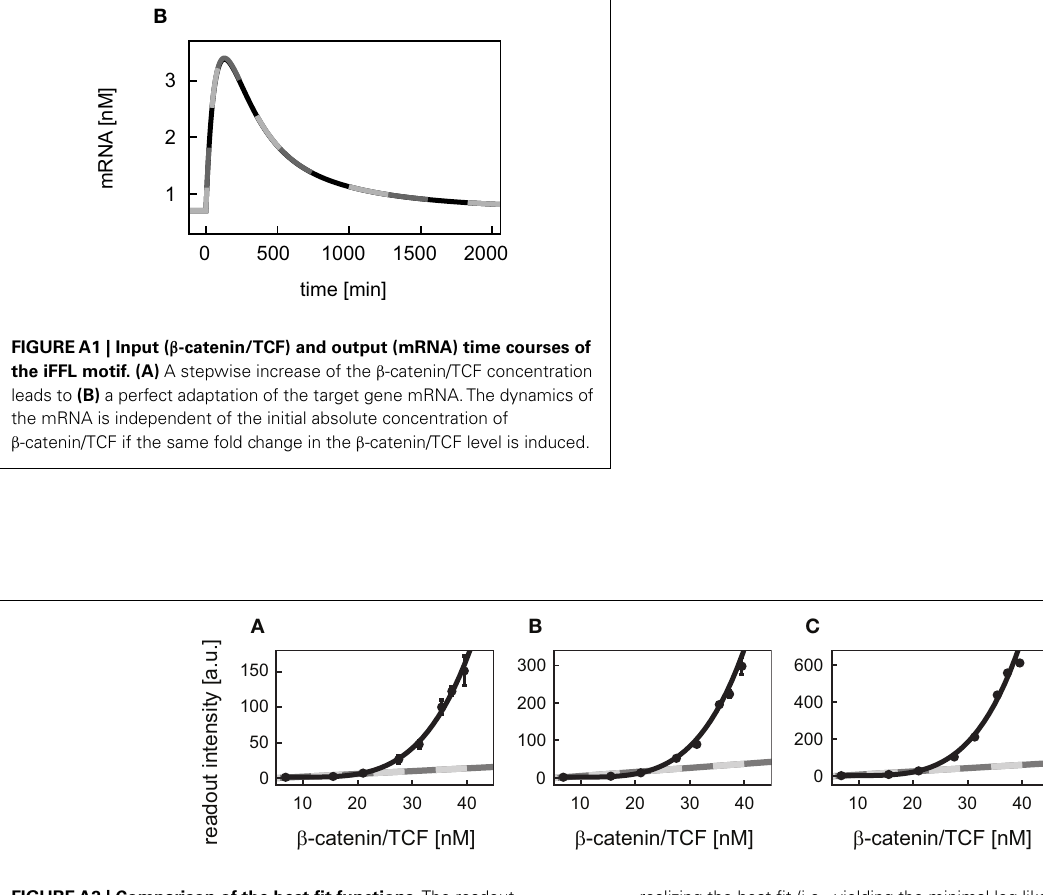
FIGUREA2 | Comparison of the best fit functions. The readout intensity of the reporter constructs with 8, 12 (transfected), and 12 (integrated)TBEs (A–C) are plotted with standard deviations.The linear activation function (light gray), the Michaelis–Menten activation function (dark gray), and the Hill-type activation function (black)